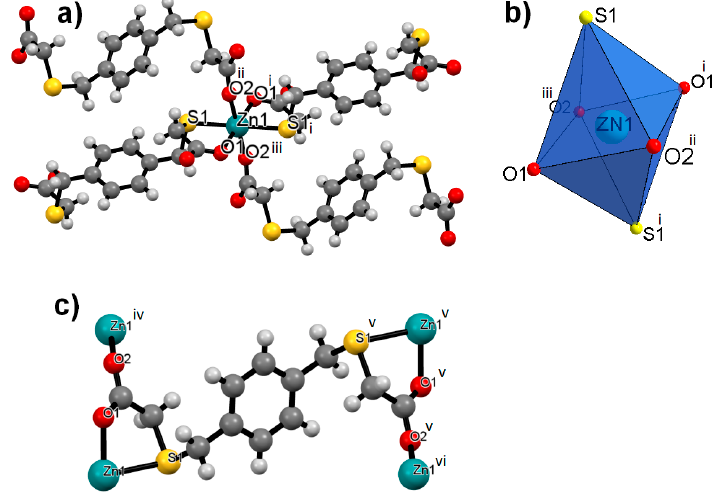
Figure 2. Structural fragments of 1H . Coordination environment ( a ) and polyhedron ( b ) of Zn1 center. ( c ) Coordination mode of µ 4 - p -XBT 2 − . Symmetry codes: (i) -x, -y, -z; (ii) x, -1 / 2-y, -1 / 2 + z; (iii) -x, 1 / 2 + y, 1 / 2-z; (iv) -x, -1 / 2 + y, 1 / 2-z; (v) 1-x, -y, 1-z; (vi) 1-x, 1 / 2 + y, 1 / 2-z.